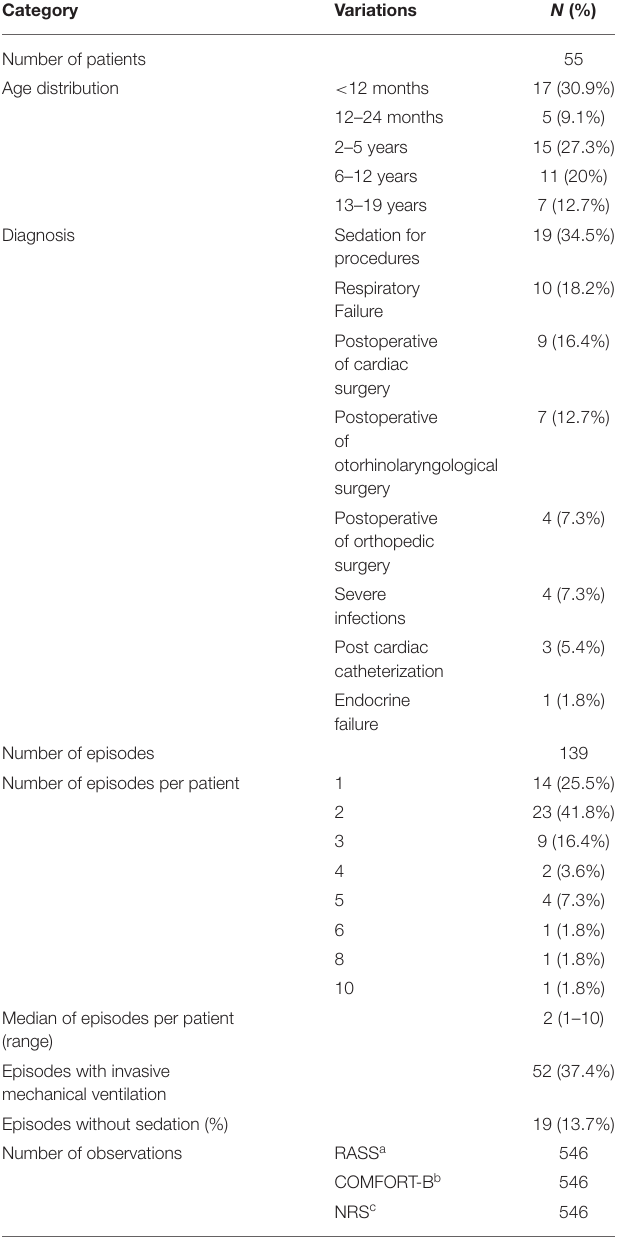
TABLE 1 | Patient characteristics and